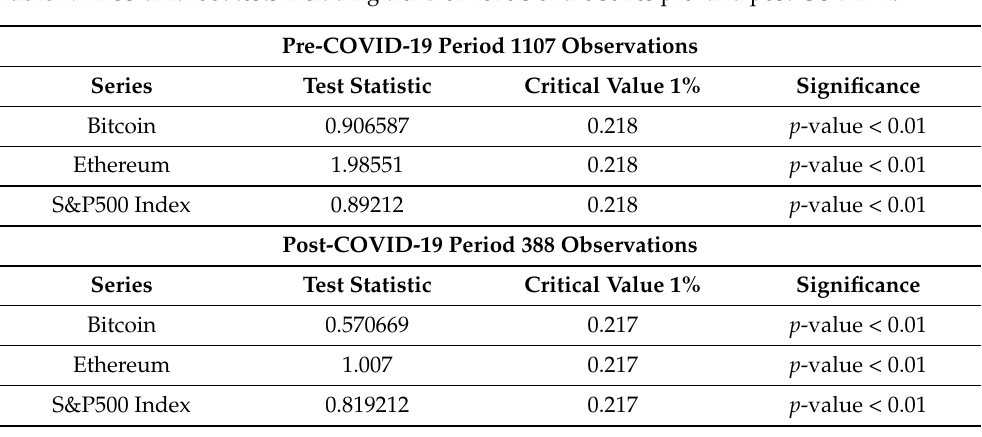
Table 1. KPSS unit root tests including trend on levels of the series pre- and post-COVID-19.